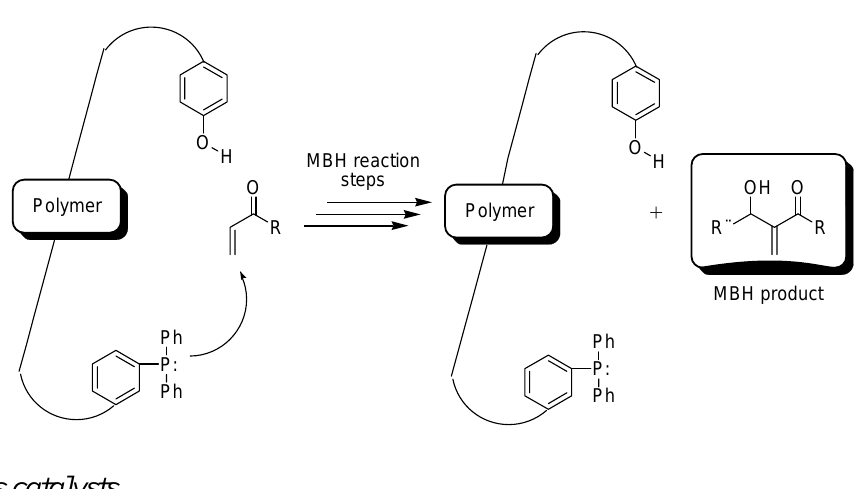
Figure 8. Polymer catalyzed MBH